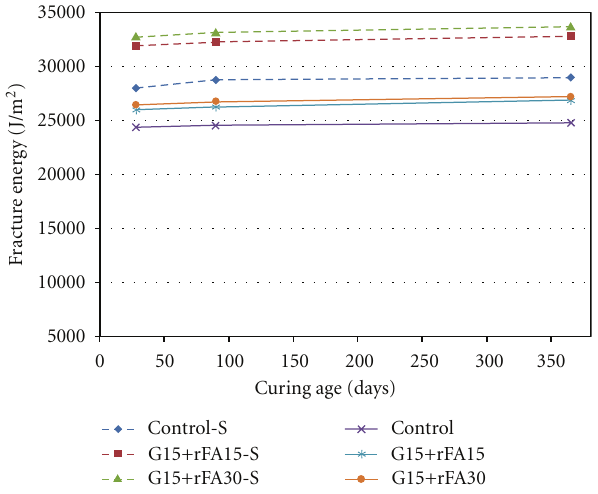
Figure 10: E ff ect of both GP and r-FA on fracture energy of UHPFRC with and without steam